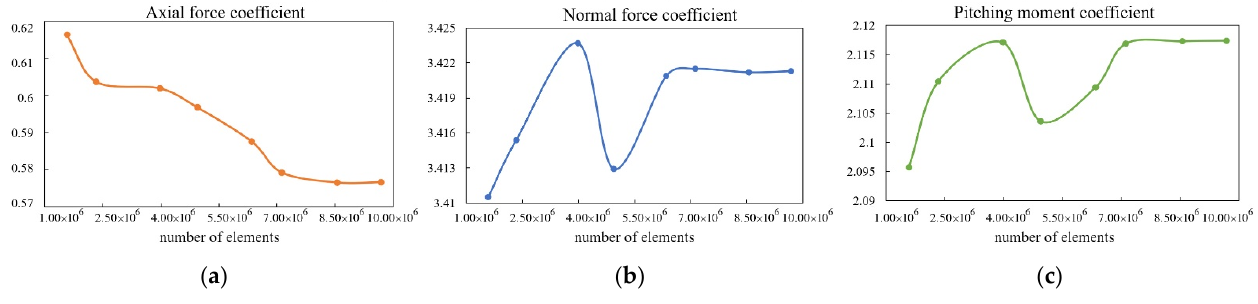
Figure 3. Grid independence verification of the axisymmetric vehicle. ( a ) Axial force coefficient, ( b ) normal force coefficient, ( c ) pitching moment coefficient. Table 2. Aerodynamic coefficients under different grid numbers.